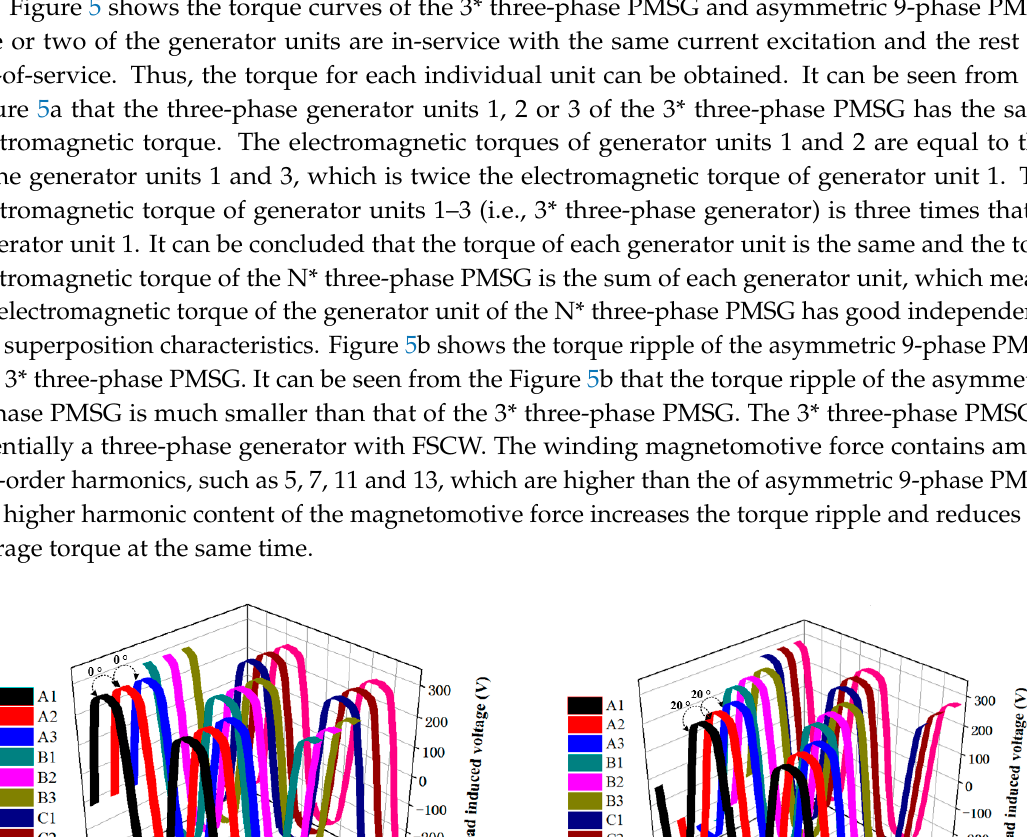
( b ) electromagnetic torque fluctuation Figure 5. Torque curves of the generators. Figure 6 shows the flux distribution of a 3* three-phase PMSG when phase B1 is fed with rated current, while B2 and B3 are in an open circuit condition. It can be seen from the Figure that there is a weak magnetic coupling between B1, B2 and B3. The mutual-inductance between B1, B2 and B3 is thereby much lower than the self-inductance of B1. The FEA result shows the self-inductance of B1 is 0.233 mH and the mutual-inductance between B1, B2 and B3 is 0.0245 mH, only 10.5% of self-inductance. Thus, the cross-coupling effect between the generator units can be ignored. During the manufacturing